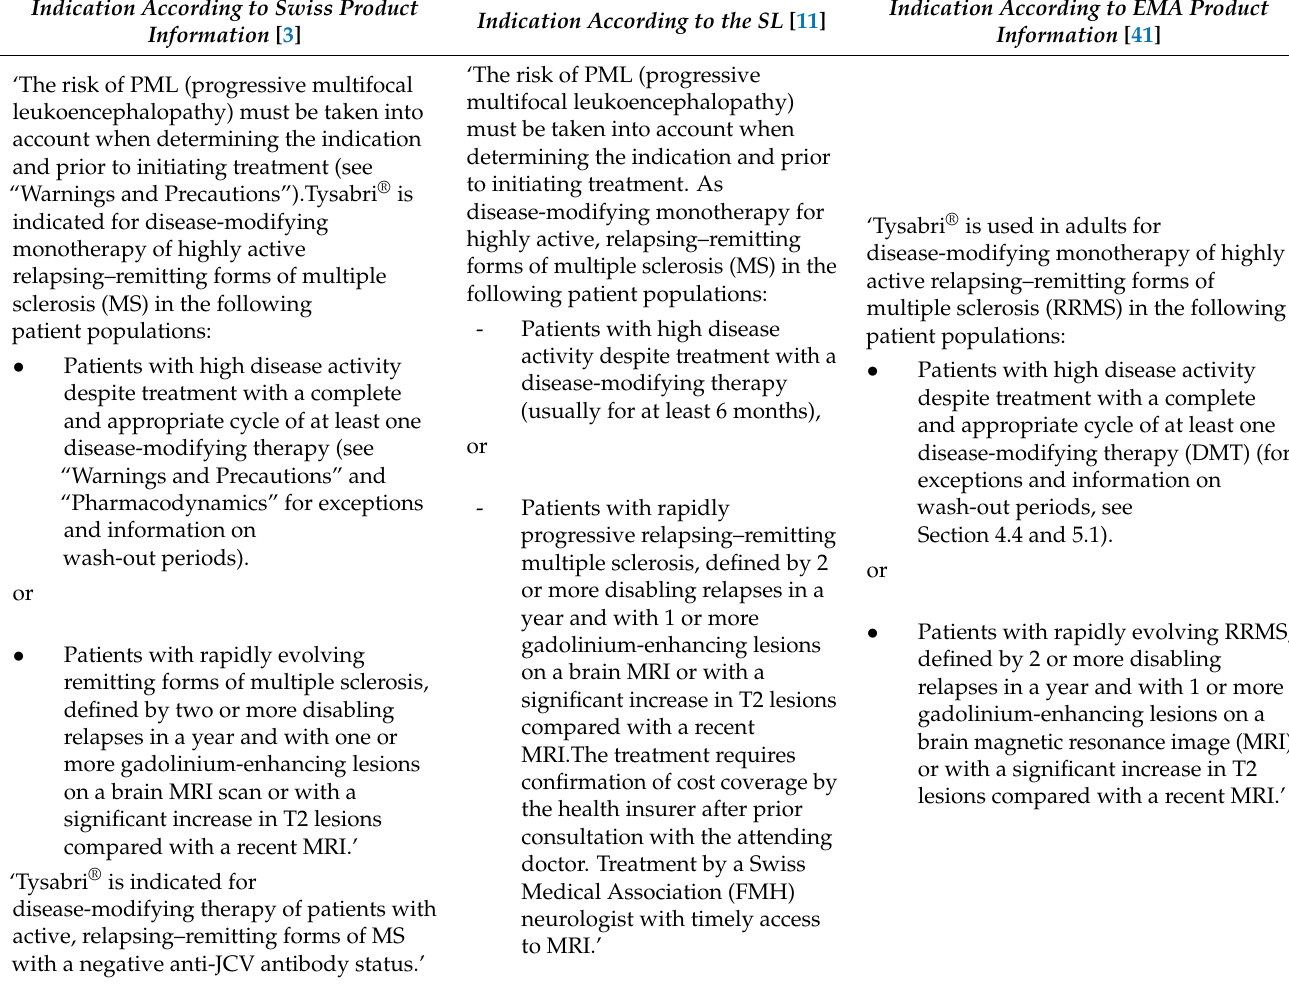
Table 12. Natalizumab (Tysabri ® ) intravenous and